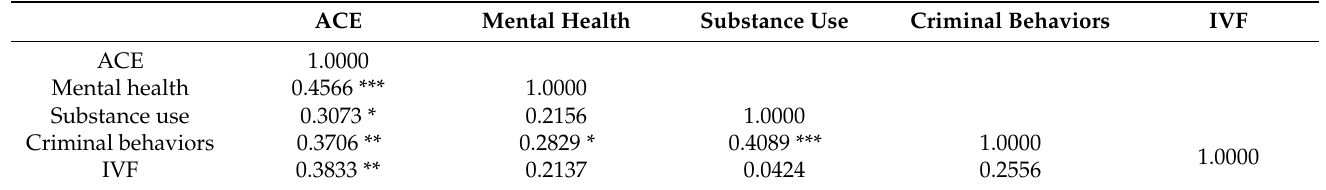
Table 5. Correlation between ACEs and impact on mental health, criminal behaviors, alcohol and/or substance use, and IFV in men.